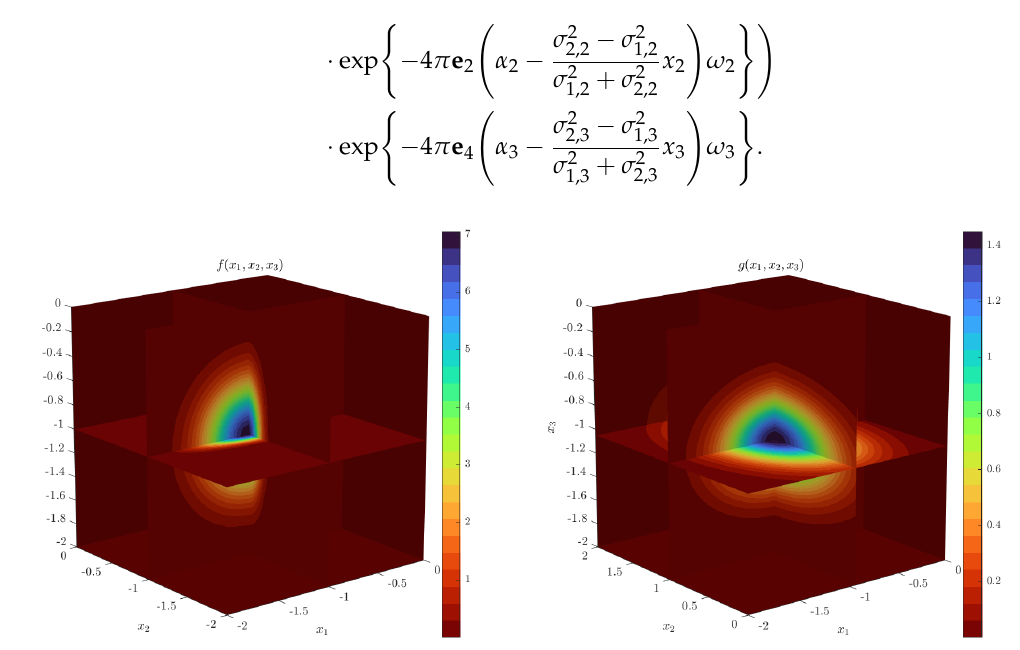
= ( − 1, − 1, − 1 ) , µ = ( − 0.95, + 1, − 1.05 ) , 1 2